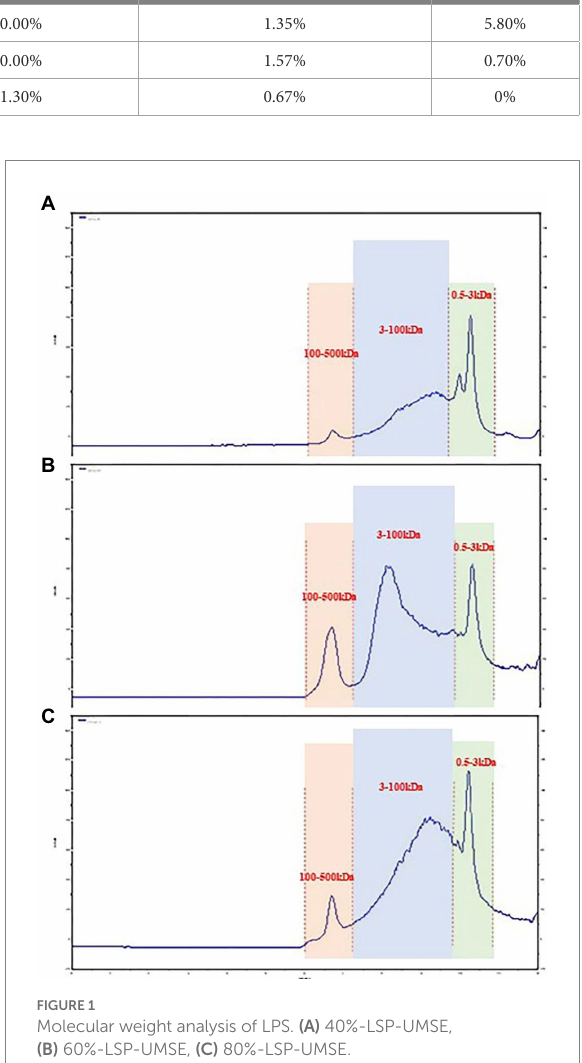
FIGURE 1 Molecular weight analysis of LPS. (A) 40%-LSP-UMSE, (B) 60%-LSP-UMSE, (C) 80%-LSP-UMSE.